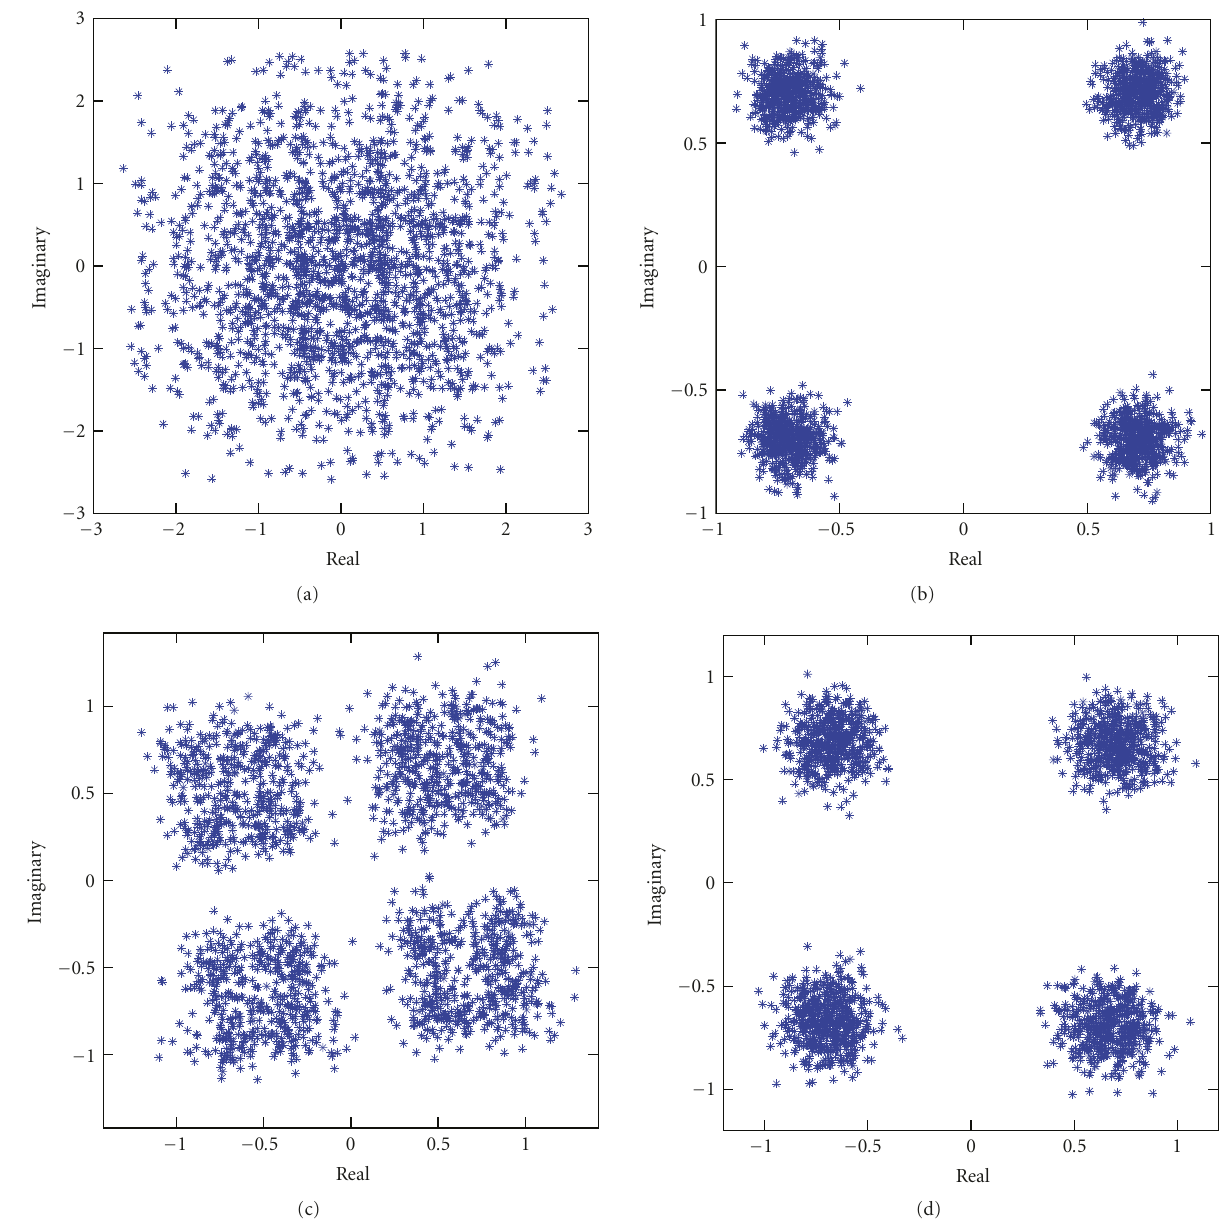
Figure 7: (a) QPSK constellations before equalization, (b) after equalization using GPS, (c) after equalization using CMA0, and (d) after equalization using